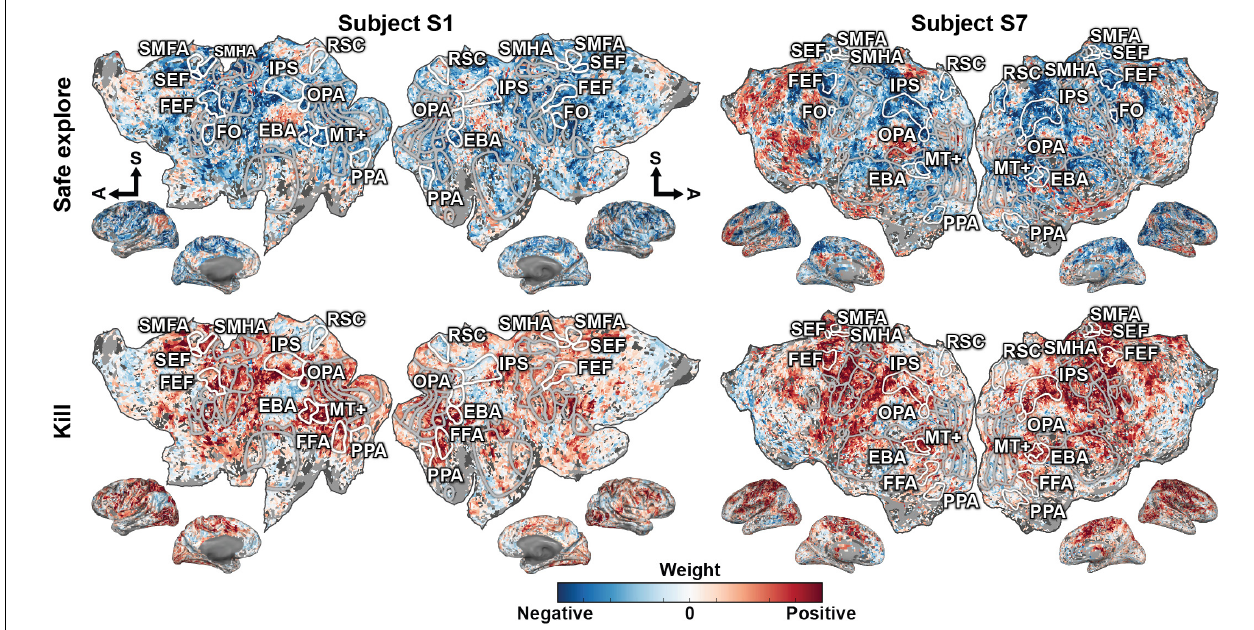
FIGURE 4 | Behavioral states in the video game task are represented in broad functionally specialized networks distributed across the cerebral cortex. The representations fall into two general groups that share overlapping regions. Weights for one state dimension from each group, “safe explore” and “kill,” are shown on the flattened cortical surfaces for both subjects. Blue correspond to negative weights, white to no weights, and red to positive weights. Voxels are thresholded by the prediction performance of an encoding model at a Bonferroni-corrected p < 0.05 significance level. Selected ROIs are highlighted and labeled. Inflated cortices are shown for reference. The axes for “dead,” “safe explore,” “round start,” “flash,” and “unsafe explore” share representation in the TPJ, precuneus, and prefrontal cortex. The axes for “kill,” “engage close,” “run away,” and “engage far” share representation in the motor, pre-motor, and supplementary motors areas, and also in IPS, FEF, and SEF. These model weights further suggest that task variables in complex and open-ended tasks are also represented in a low-dimensional subspace of cortical